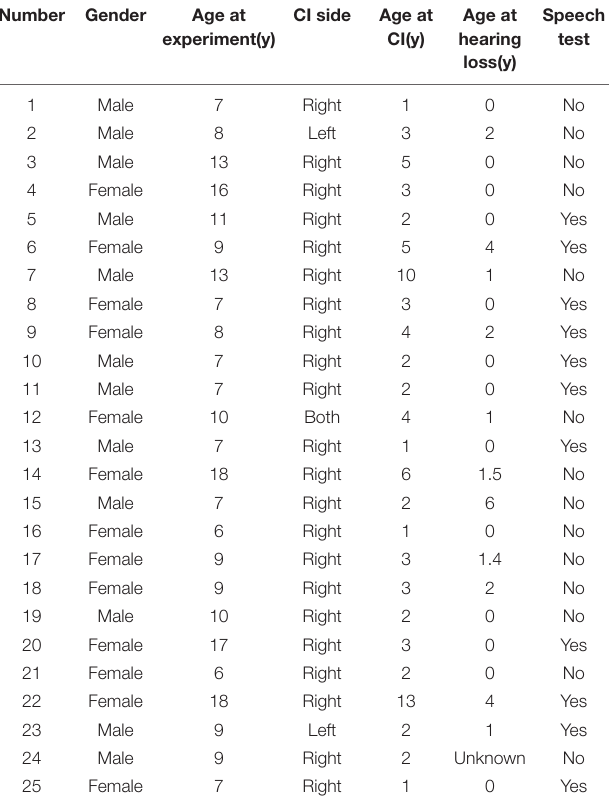
TABLE 1 | Information of all participants in this